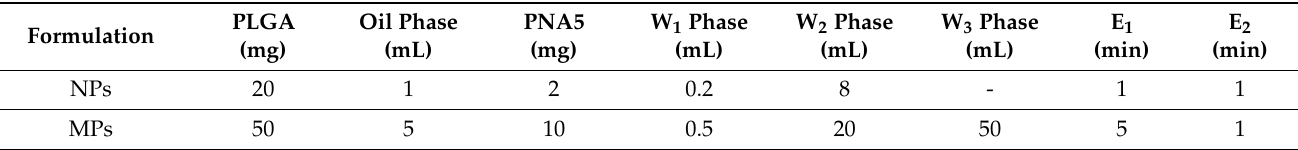
Table 1. PNA5 loaded-PLGA microparticles (MPs) and nanoparticles (NPs): composition of formula- tions and manufacturing